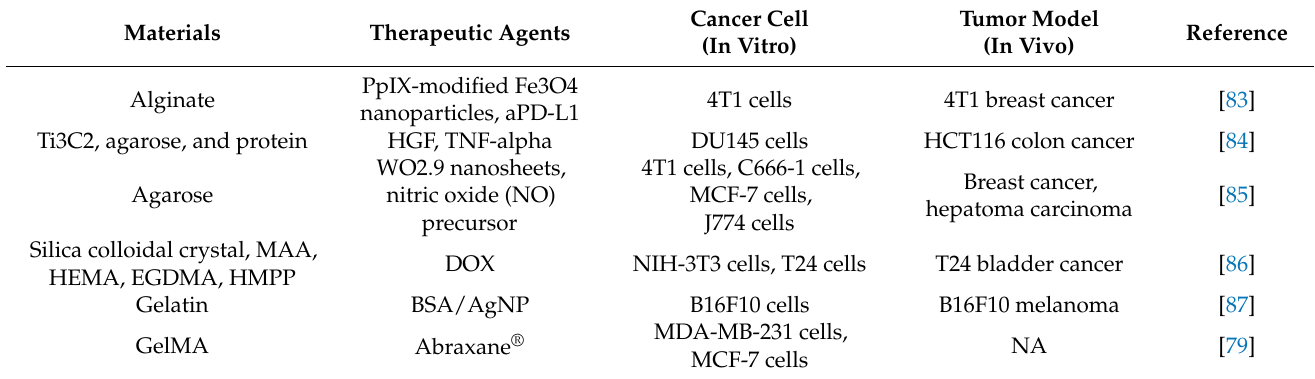
Table 3. Examples of light-responsive hydrogels recently developed for localized cancer